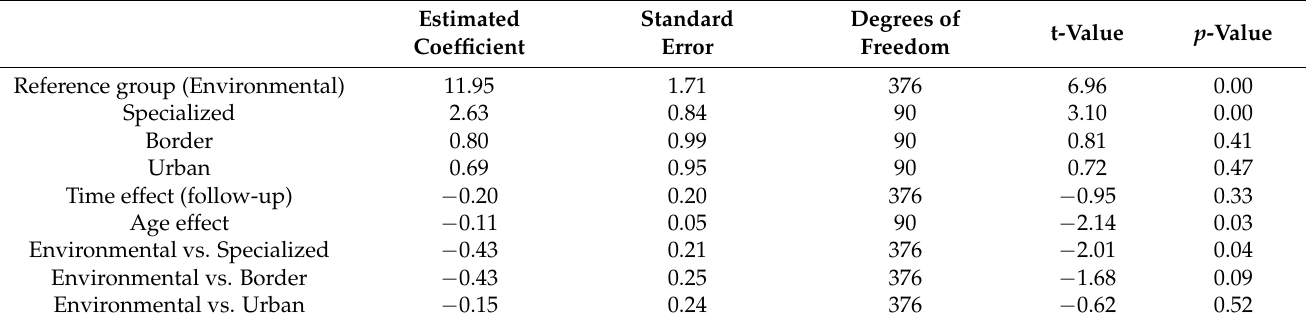
− 2.73 repetitions ( β specialized:time = − 0.65; p < 0.05), while the Urban group showed a